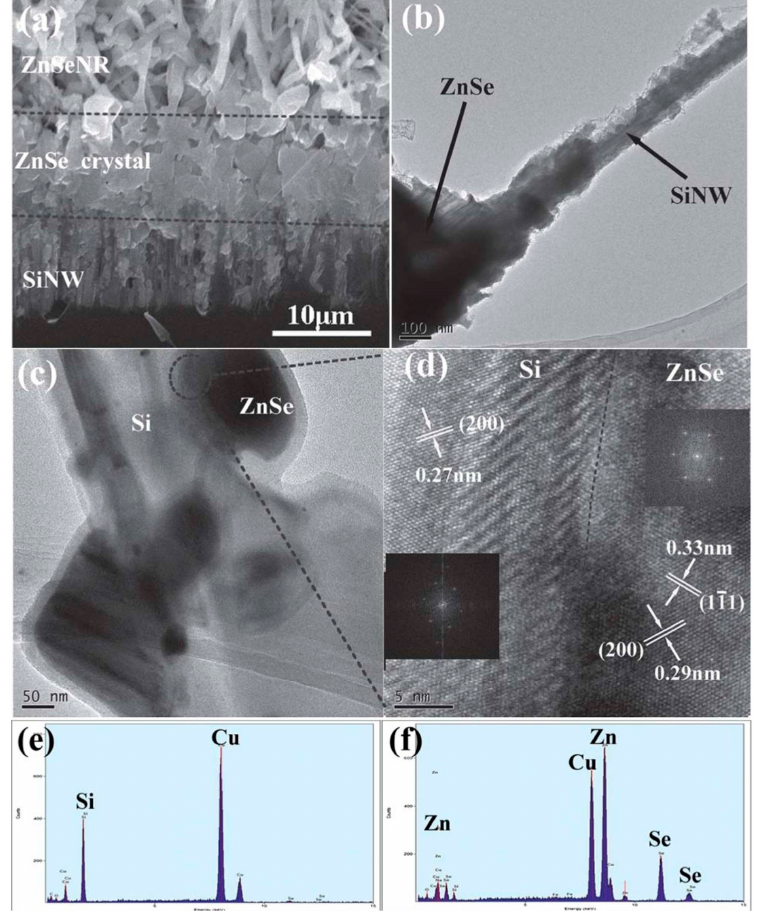
Figure 5. ( a ) Cross-section FESEM image of the ZnSeNR/SiNW heterojunction array. ( b , c ) TEM images of a single SiNW covered by the ZnSe layer. ( d ) HRTEM of the SiNW and ZnSe interface detected at the circle region in ( c ). The junction interface was marked with a dashed line. Insets show the fast Fourier transform (FFT) patterns of the SiNW (left) and ZnSe (right). ( e ) EDX spectrum of the SiNW taken from the light area in ( c ). ( f ) EDX spectrum of the ZnSe taken from the dark area in ( c ). Cu peaks come from the Cu grid used for TEM investigation. Reproduced with permission from [38], Copyright 2011, The Royal Society of Chemistry.